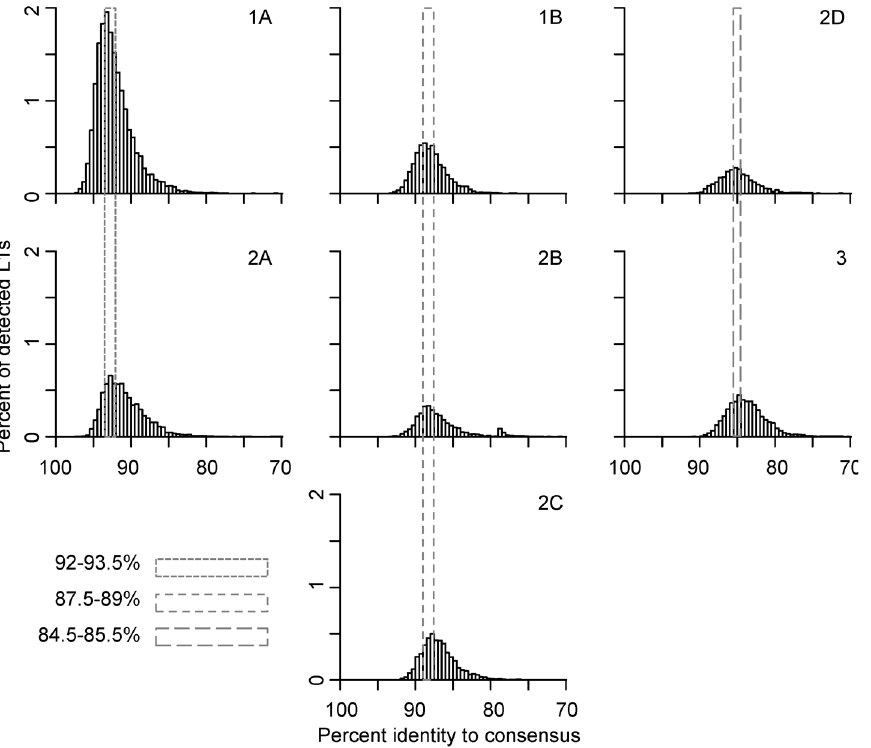
Figure 2. Persistence of concurrently active L1 families. Concurrent L1 families are arranged vertically. Names of families are noted on the top- right corner of each panel. L1 ages are determined by their percent identity to the corresponding subfamily consensus in 0.5% windows – the higher the percent identity, the younger the element. L1 copy numbers are normalized as percent of total detected L1s. The retrotransposition peaks of concurrent families are marked with dashed-line boxes; smaller dashes indicate younger families.